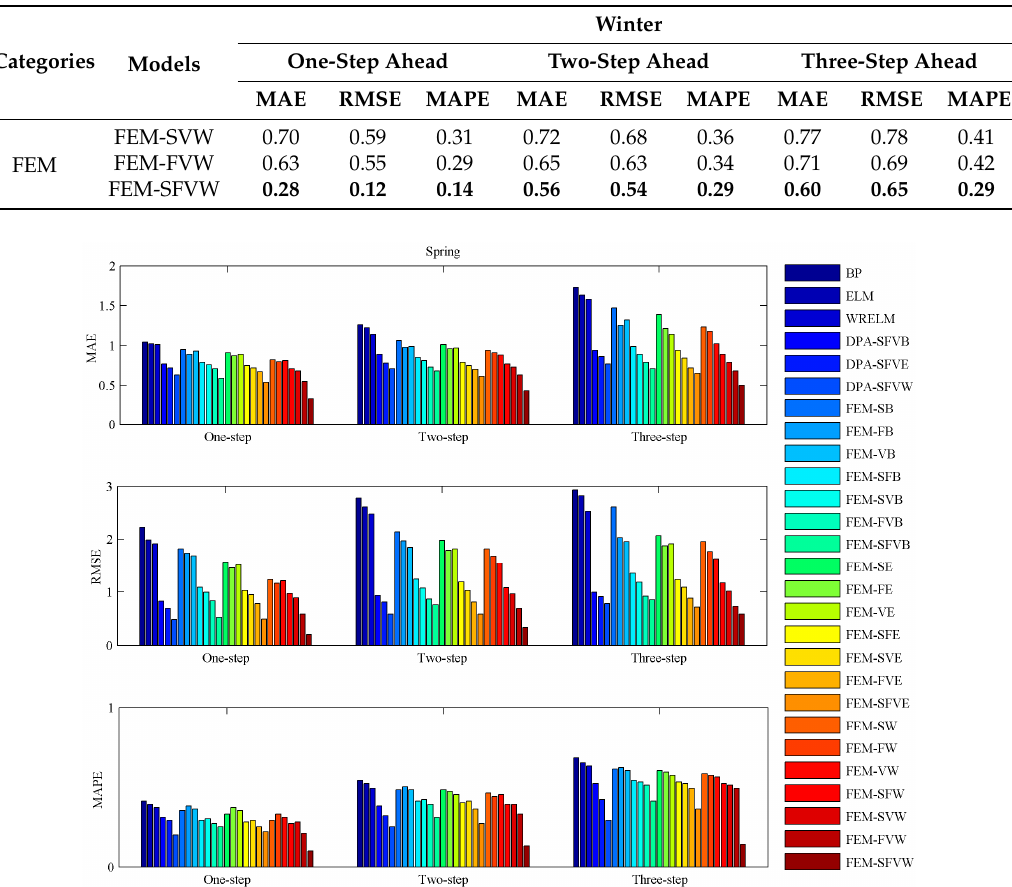
Figure 11. Performance comparison of different models in terms of MAE, RMSE and MAPE in spring.